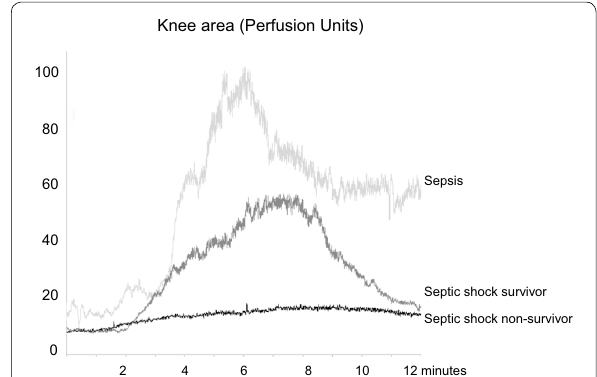
Fig. 2 Examples of skin microcirculatory endothelial reactivity in the knee area in a patients with sepsis, in a patient with septic shock that was alive at day 14 and in a patient with septic shock that was ultimately dead at day 14. Skin microcirculatory blood flow was measured at baseline and after acetylcholine iontophoresis. Adapted from